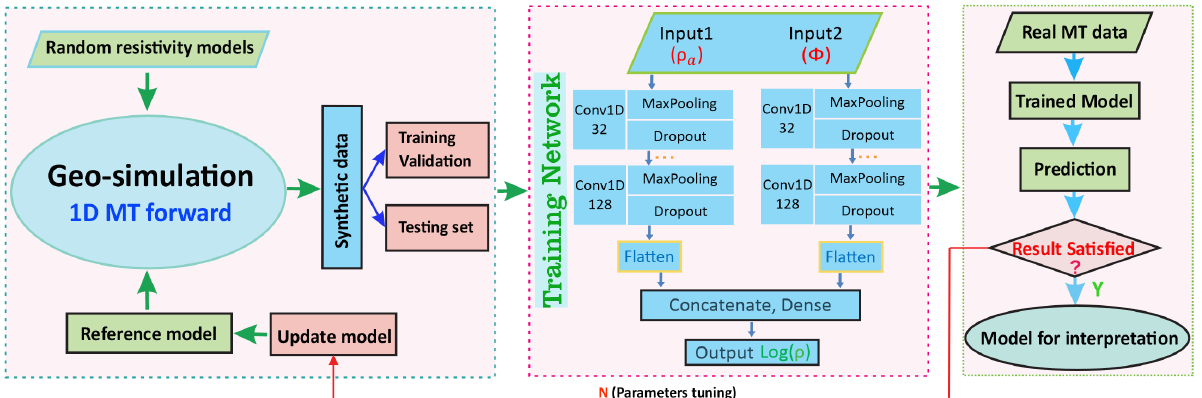
Figure 2. A schematic work fl ow of the MT CNN inversion used in this study ( left : resistivity model generation and forward response. Paired datasets are split for model training and validation; middle : A schematic network architecture displaying input and output for optimizing model parameters. More details of the U-net structure can be found in [12,14]; right : With a trained NN model, the datasets are used as inputs to calculate resistivity).